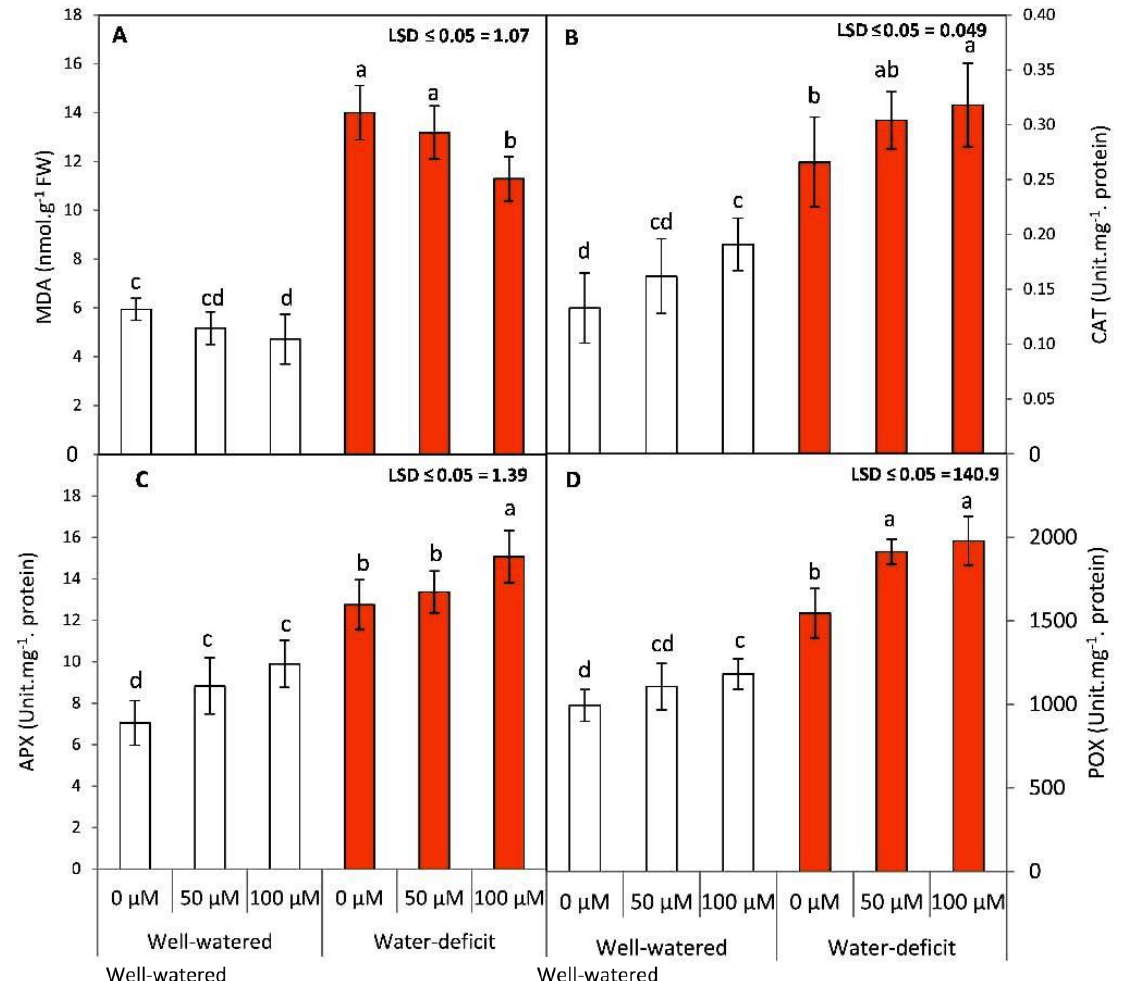
Figure 4. Effects of SNP as foliar applications at 0, 50, and 100 µ M on malondialdehyde ( A ), catalase ( B ), ascorbate peroxidase ( C ), peroxidase, and ( D ) guaiacol peroxidase of tomato plants grown under well-watered and water deficit irrigation. Data followed by the same letters are not significantly different using the LSD multiple rang test at a 5% level.